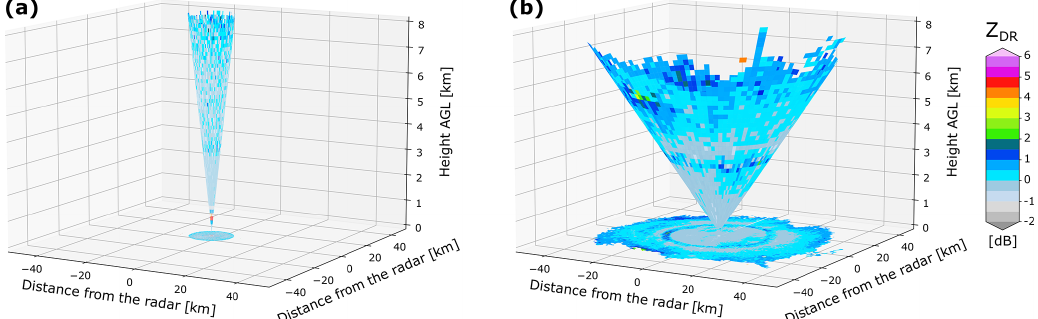
Figure 2. Representation of the radar conical coverage using (a) a birdbath scan, useful for building VPs, and (b) a 9 ◦ PPI scan, used to generate QVPs.